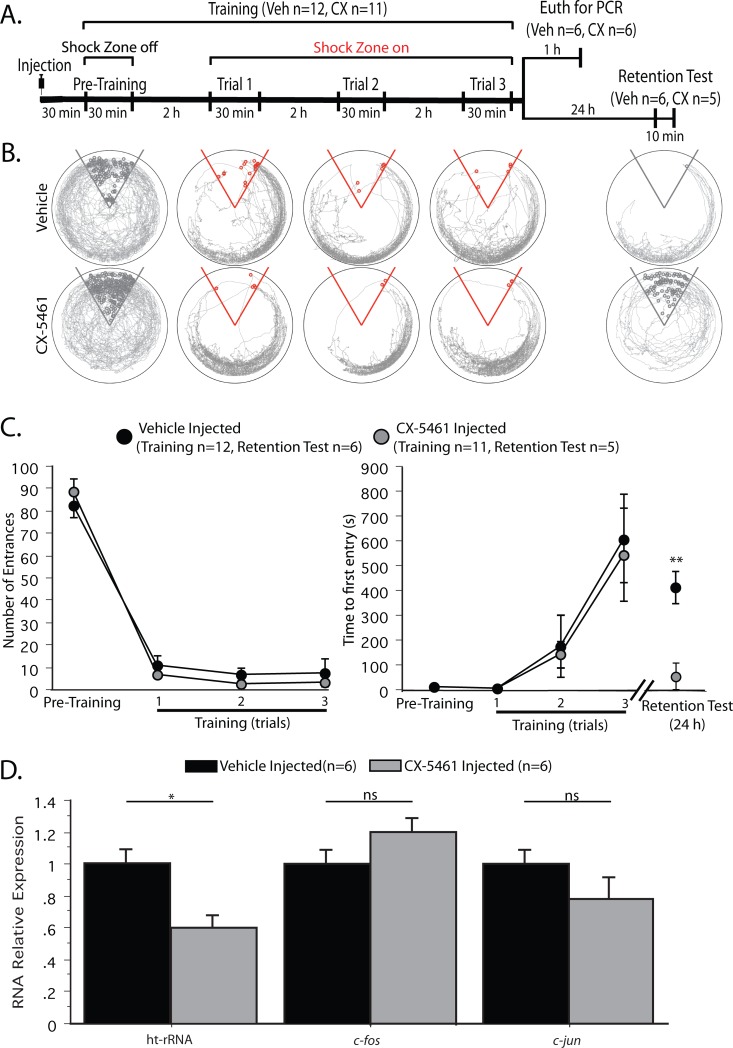
RNA Pol I inhibitor, CX-5461, disrupts consolidation of long-term memory, but not learning.A) Timeline of the training protocol. Note that half of the animals were euthanized 1 h after the third training trial for qPCR analysis (see 3D) while the remainder were given a retention test 24 h later (see 3C). B) Representative paths (trajectories) of animals during pre-training, training and the 10 min retention test given 24 h after the 3rd training trial (grey tracings). Red circles indicate the animal’s location when a shock was received. Grey circles indicate the position of the animal where it would have received a shock had the shock zone been active. C) Comparison of learning and memory between APA trained mice who received intracranial injection of vehicle (black circles) and CX-5461 (grey circles). Left, Number of entrances during the 30 min trials. No significant difference in the number of entrances indicates equivalent learning of CX-5461 treated animals and vehicle-treated controls. Right, Time to first entry the shock zone during each training trial and on the 24 h retention test. There were no significant differences in between-trial memory or between the two groups during training. In contrast, the vehicle injected animals continue to show place avoidance memory 24 h later; whereas CX-5461 injected animals do not. D) Real-Time qPCR relative expression shows that CX-5461 has no effect on Pol II dependent c-fos and c-jun transcription, but does inhibit Pol I dependent rRNA transcription. *p<0.05, **p<0.01.